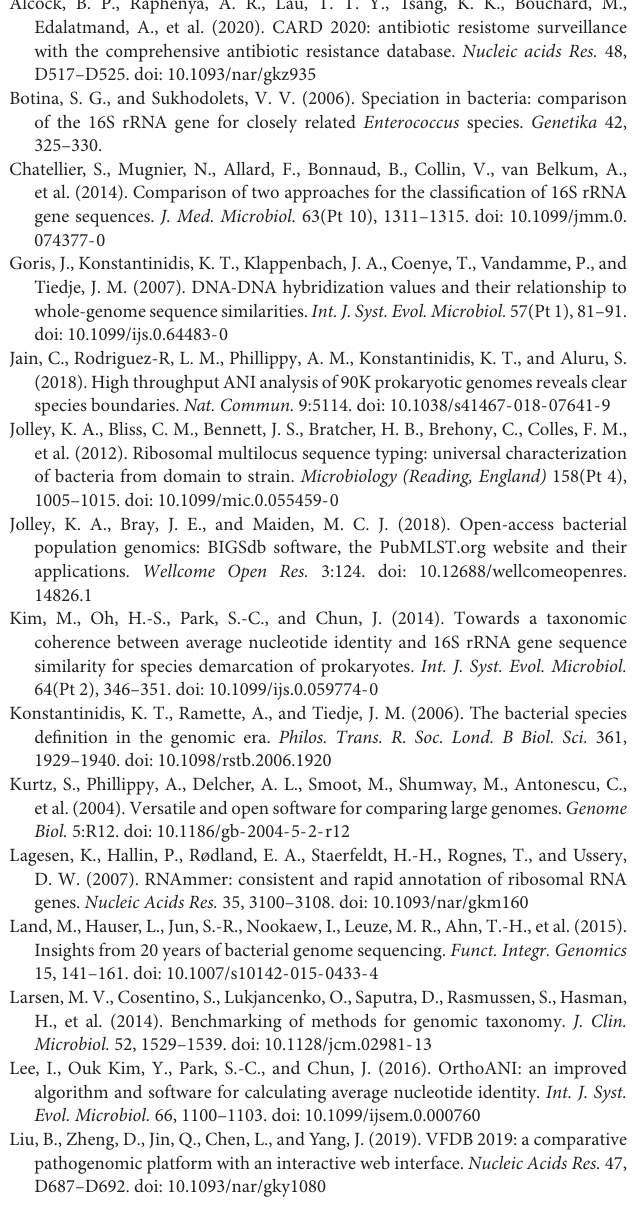
and type-strain assembly from the top 1 result of 16S alignment or KmerFinder was performed by fastANI. Supplementary Figures 3–27 | Dendrograms based on pairwise ANI values showed wrongly labeled genomes from the FDA-ARGROS and NCTC 3000 project. Genomes from FDA-ARGROS were colored green and marked by a superscript “F.” The superscript “F” was colored red if the genome was regarded as wrongly labeled. Genomes from the NCTC 3000 project were colored green and marked by a superscript “N.” The superscript “N” was colored red if the genome was regarded as wrongly labeled. Genomes without any superscript were derived from the fIDBAC curated database. Pairwise ANI calculation was performed by